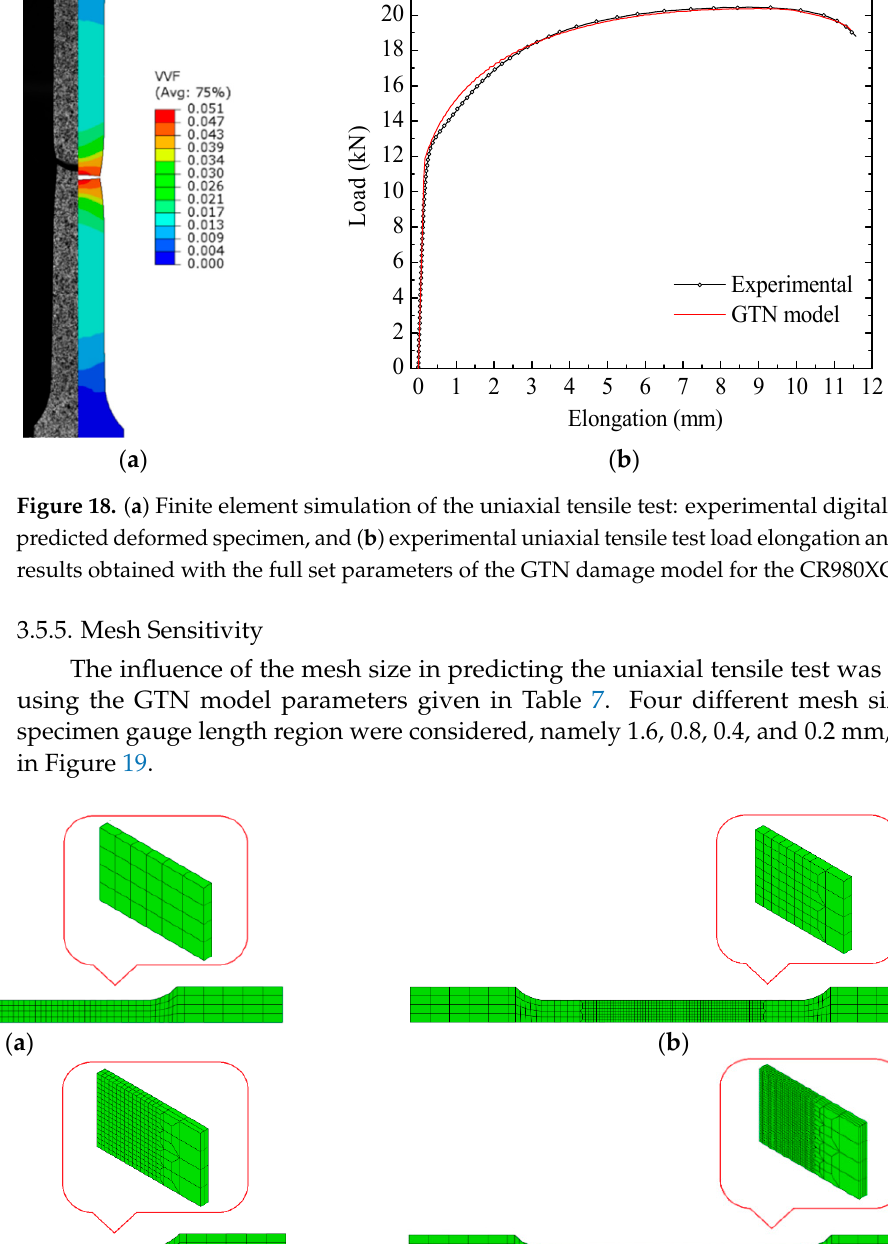
18 of 27 Figure 17. Images of the uniaxial tensile specimen during the testing at ( a ) the unloaded state, ( b ) immediately before the fracture, and ( c ) after the fracture.